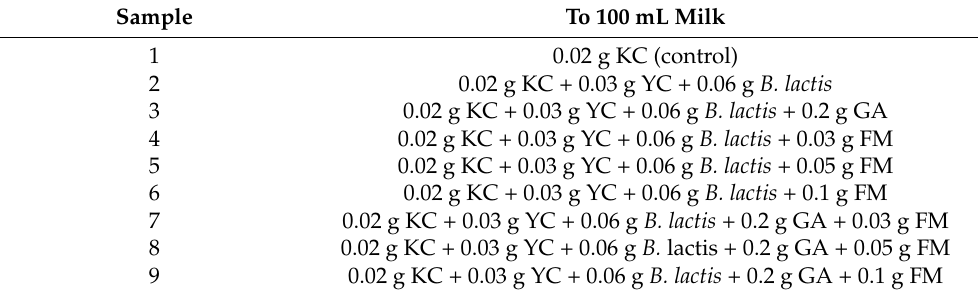
Table 1. Composition of Kefir Samples.